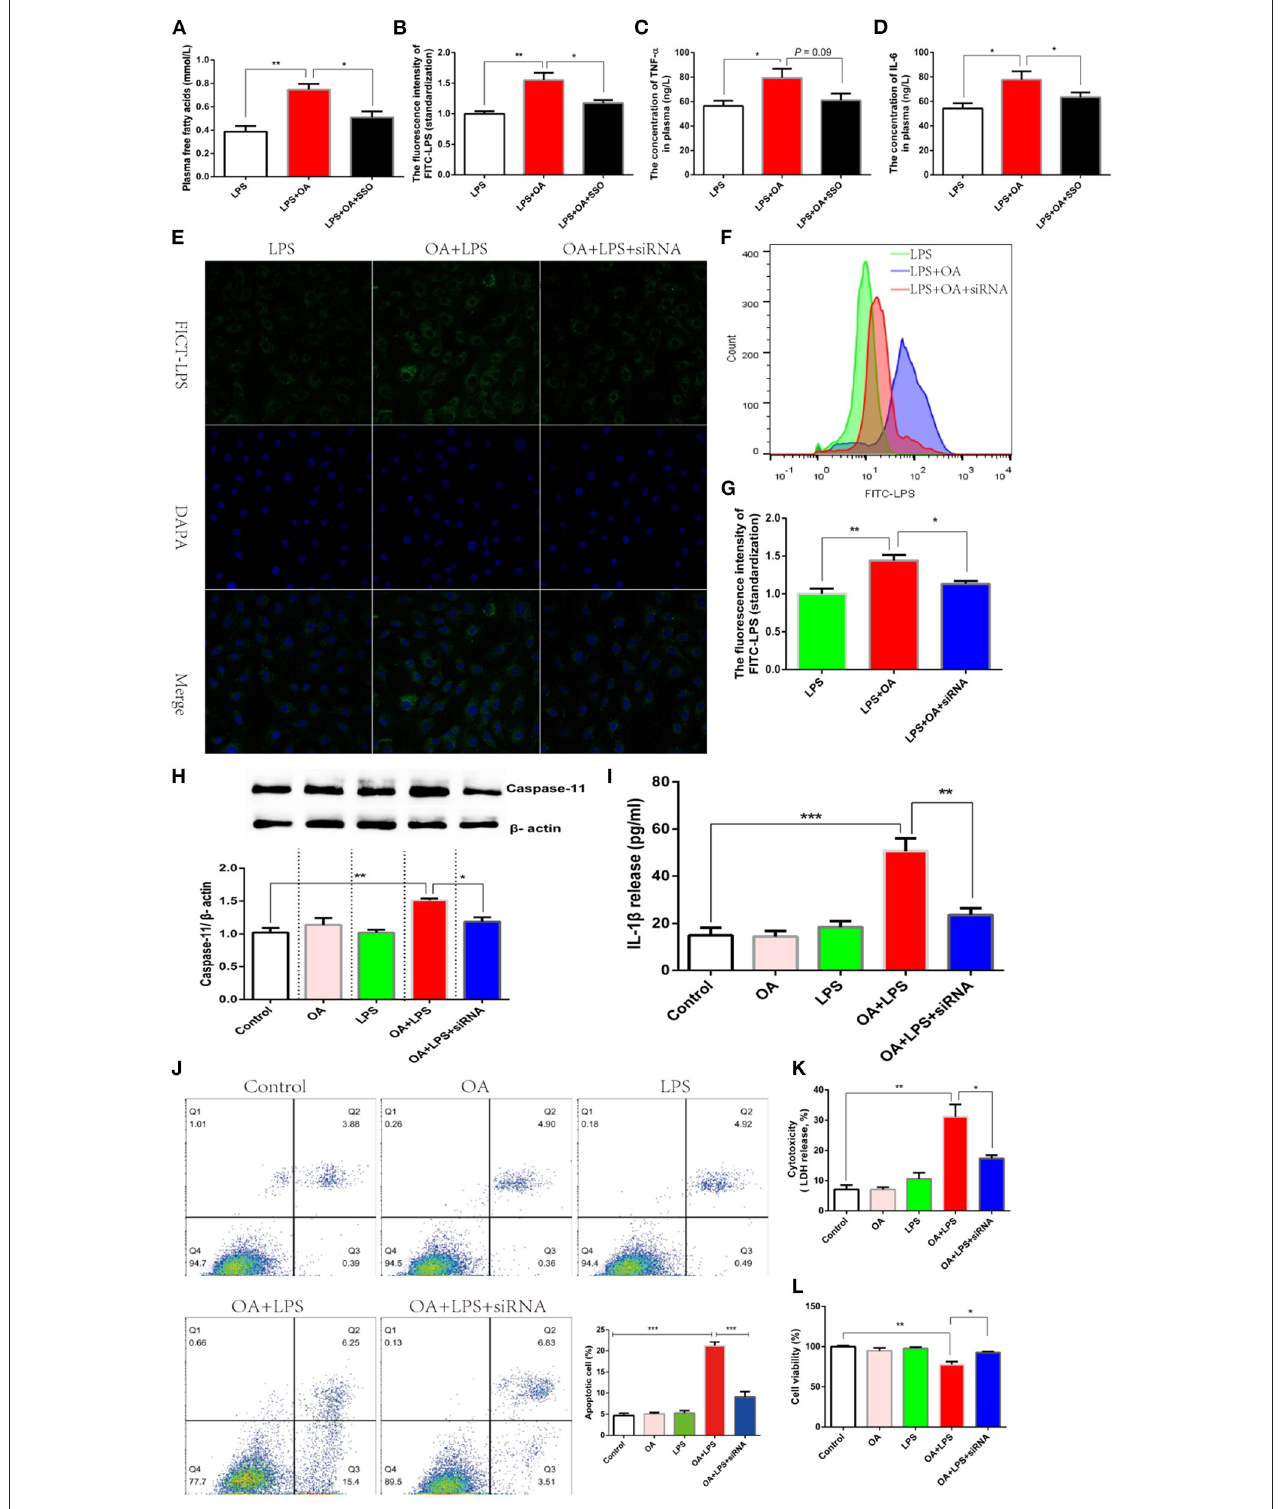
FIGURE 6 | Fatty acids facilitate the transfer of LPS through CD36. (A–D) Fish was orally administered with FITC-LPS, FITC-LPS mixed with OA, or FITC-LPS mixed with OA and SSO (CD36 inhibitor) after a diet supplemented with DSS is treated for 15 days. (A) The concentration of plasma FITC-LPS. (B) The concentration